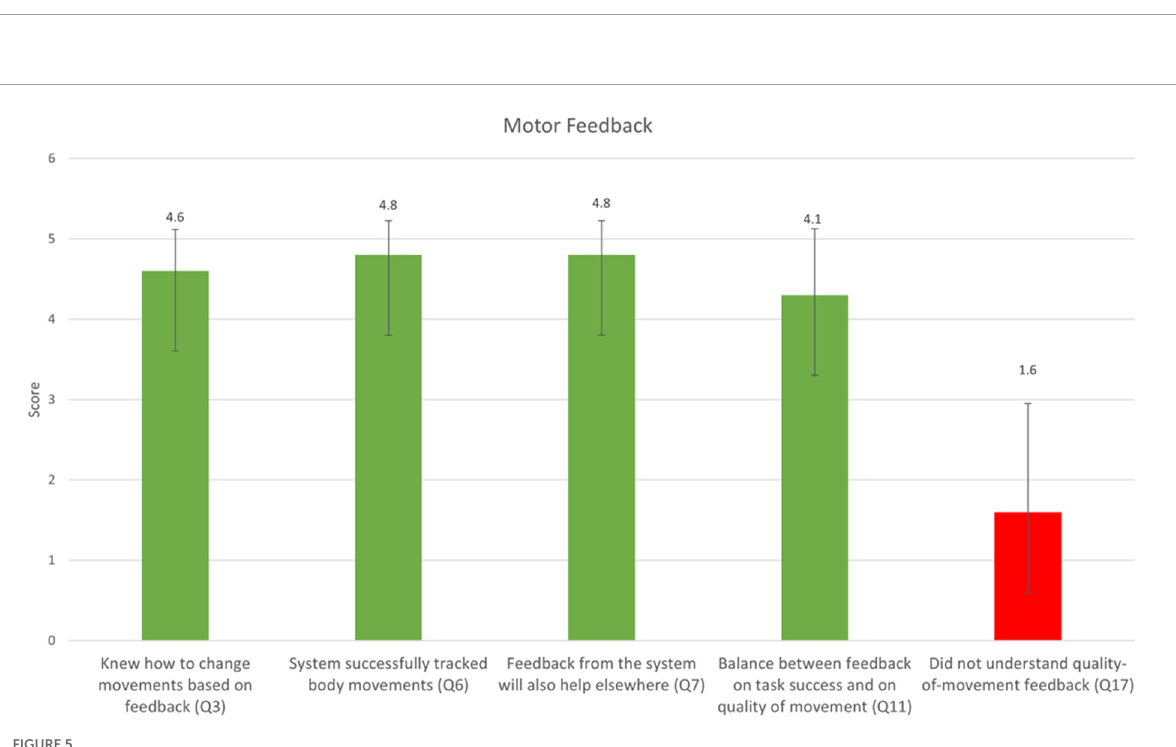
FIGURE4 Results of the 11-item modified System Usability Scale (SUS) questionnaire (mean ± SD). A score of 1 reflects “Strongly disagree” and 5 reflects “Strongly agree.” Results from the CT condition are marked in gray and results from the Motor-Feedback condition are marked in green; The “need for support” category is marked with a different color, as it was negatively worded: a lower score corresponds to higher usability of the platform. The rightmost category (“Feedback on compensations”) shows a single bar, since feedback on compensations was provided only in the MF condition.